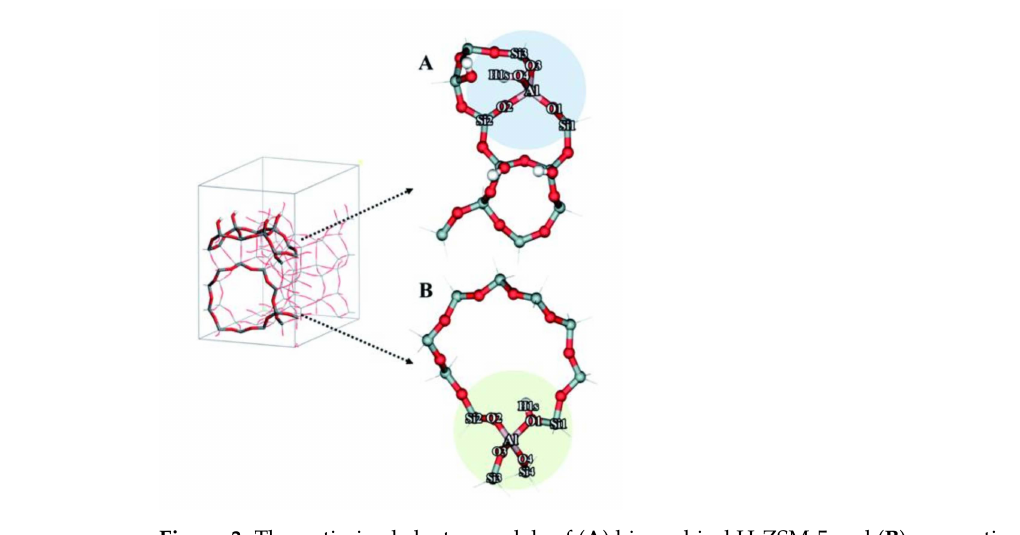
Figure 3. The optimized cluster models of ( A ) hierarchical H-ZSM-5 and ( B ) conventional H-ZSM-5. Reproduced from Ref. [53] with permission from the Royal Society of